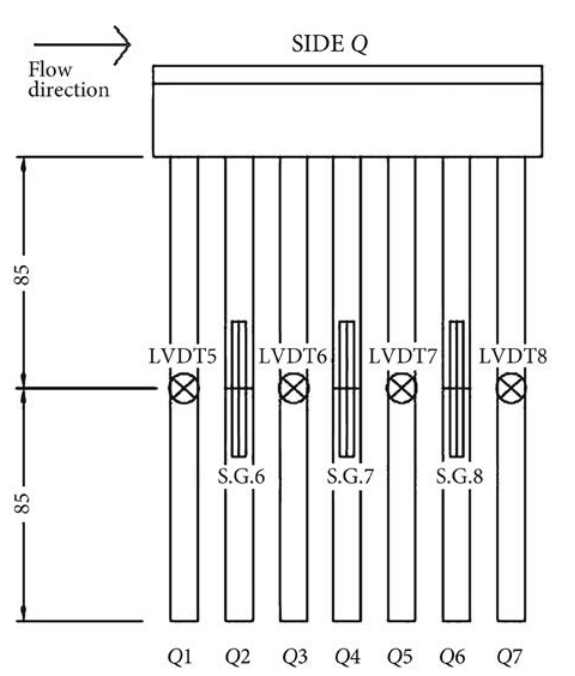
Fig. 4. Actual bridge setup during the test Fig. 6. Locations of STs and LVDTs on the Q side